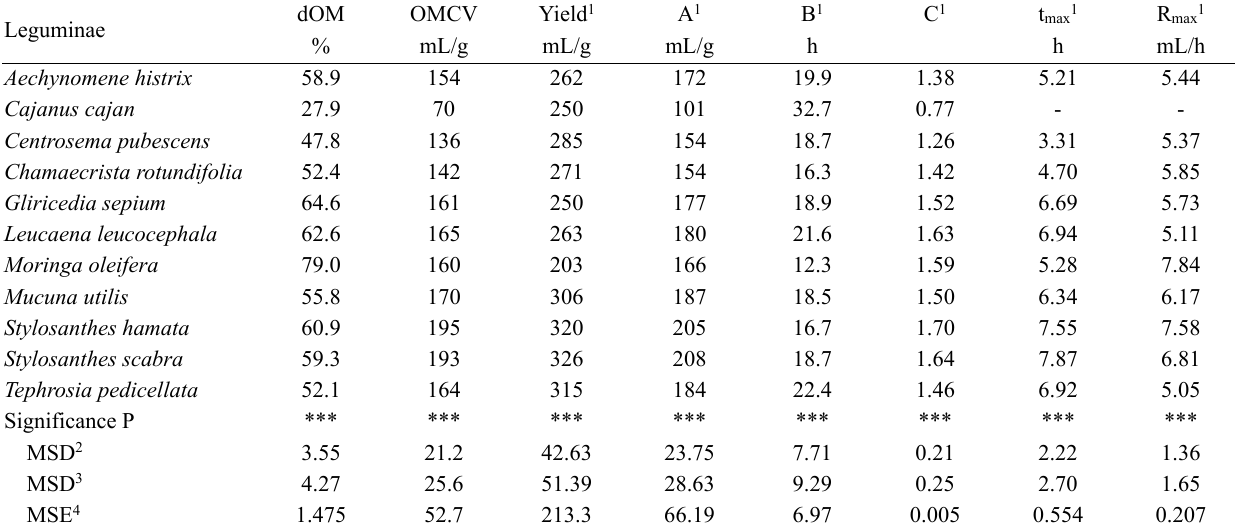
Table 4. In vitro fermentation characteristics of legumes Leguminae